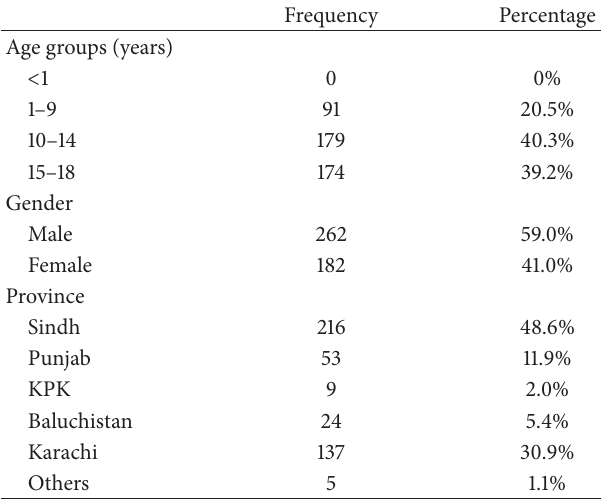
Table 1: Demographic profile of ESRD children.